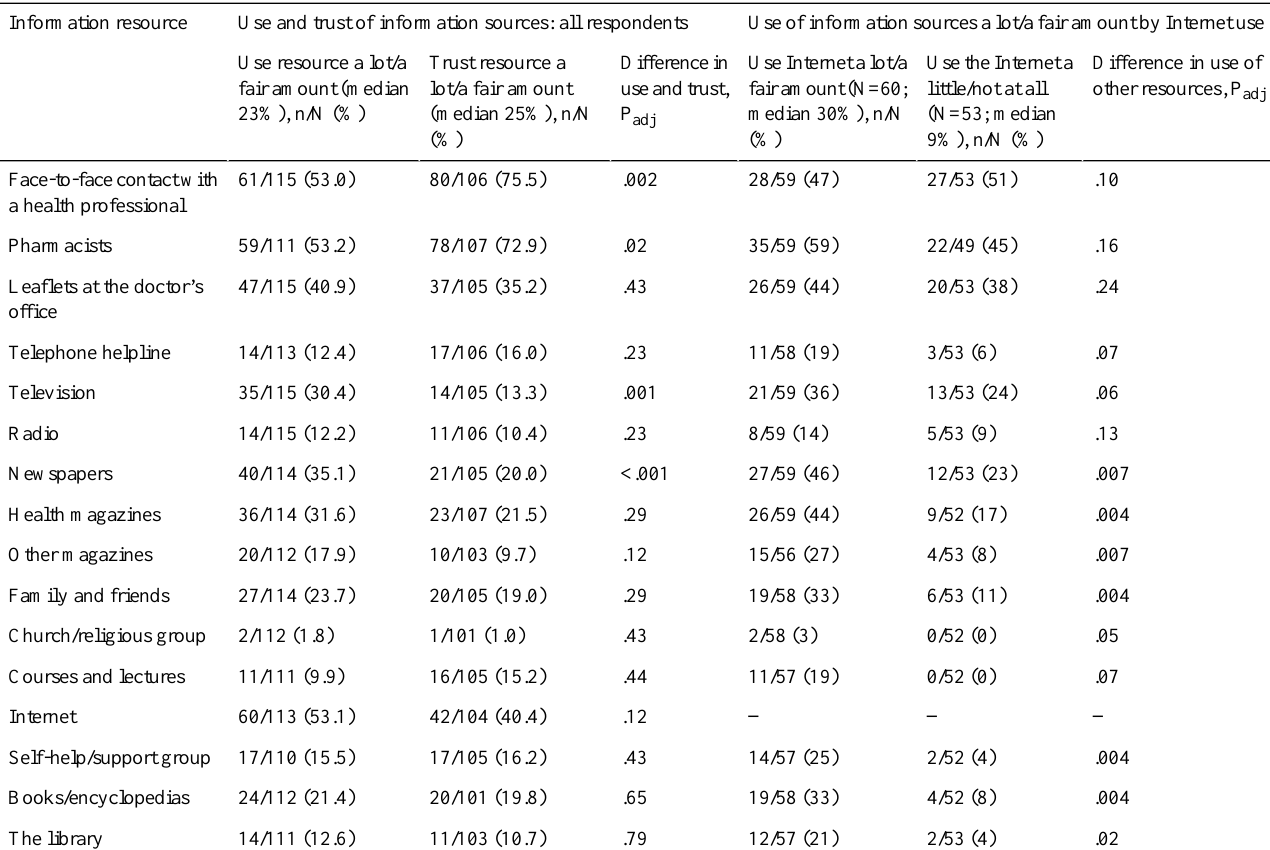
Table 2. Use and trust of health information sources and use of non-Internet health information sources by Internet use. Respondents were allowed to skip questions; therefore, the n/N is reported per question. P values are corrected for multiple